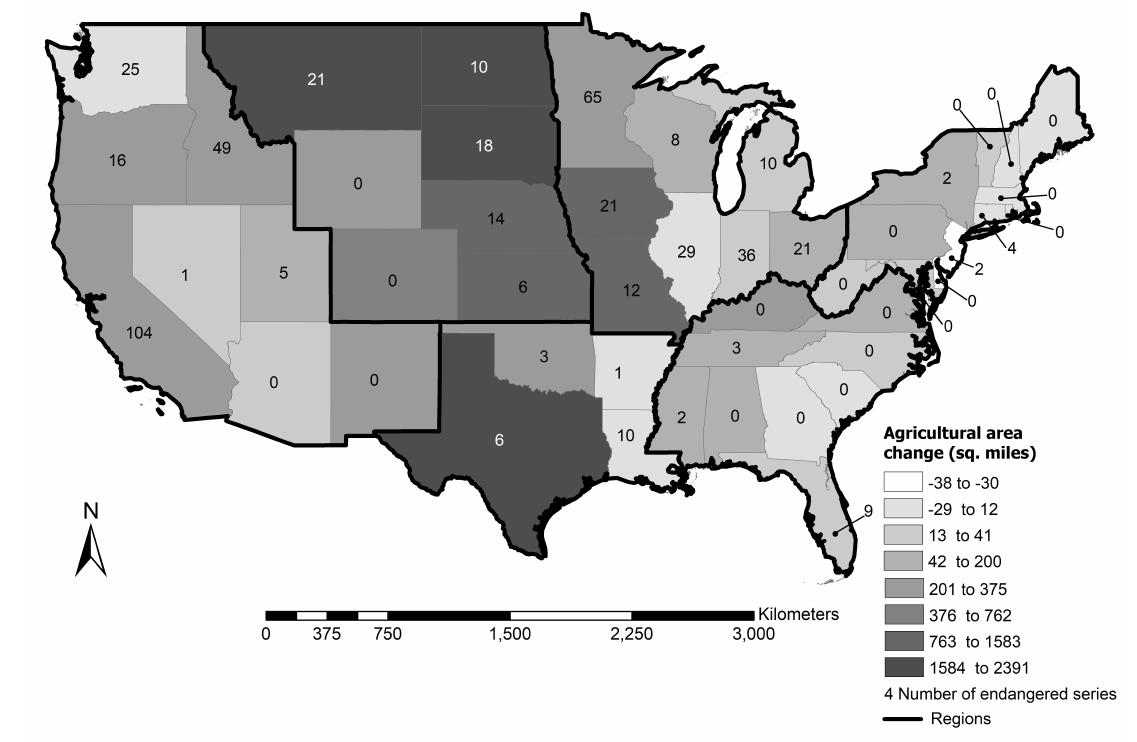
Figure 8. Agricultural land cover changes over time from 2001 to 2011 in the contiguous United States (U.S.) (adapted from Wentland et al. (2020) [65]).